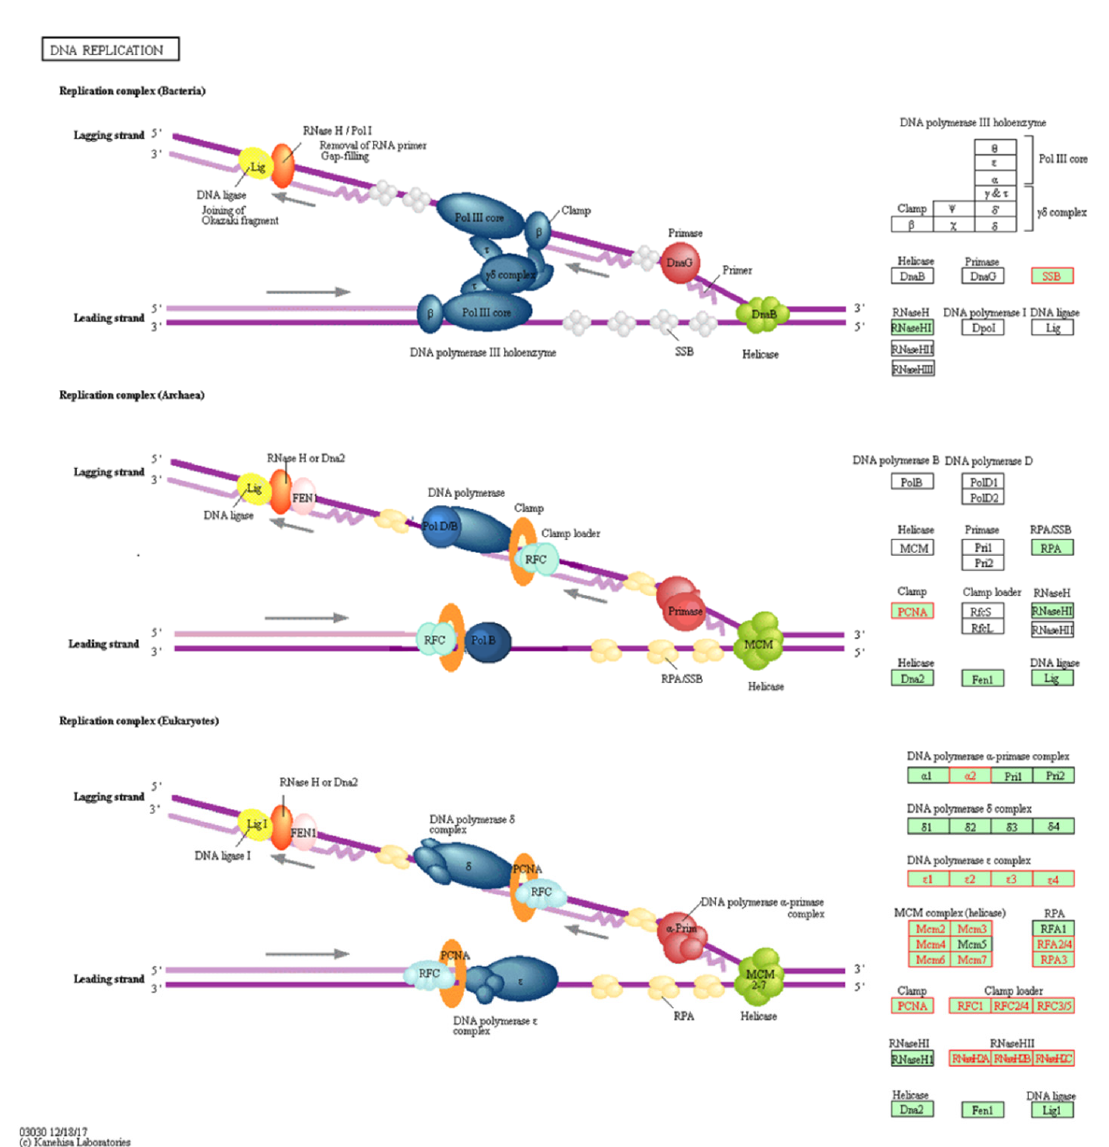
Figure 4. Illustration of DNA replication pathway in KEGG: Genes with red color are associated with upregulated proteins in KAIMRC1 compared to MCF-7 and MDA-MB-231 cell lines. Genes with green or white were not detected.